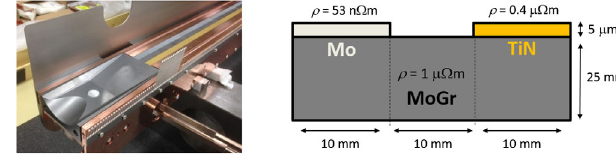
FIG. 3. The prototype collimator has two 10 mm wide low resistivity (Mo and TiN) stripes on a MoGr substrate. Left — photo of the collimator assembly; right — schematic drawing of the collimator jaw.